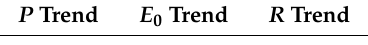
Table 2. Mann–Kendall (MK) trend test results of annual P , E 0 , and R in the Lancang River Basin (LRB). P Trend